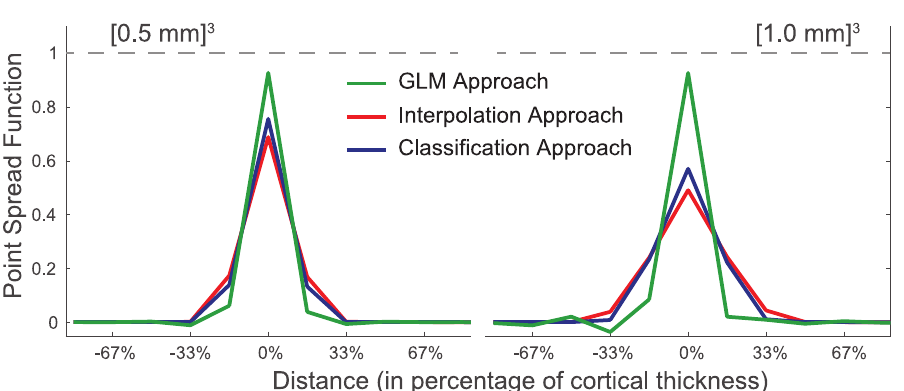
Fig 5. The performance of the three different approaches of obtaining layer signal, represented as a point spread function (PSF) obtained on simulated data. An ideal PSF would be an unit peak at the origin. The results are shown for approximate resolutions of 0.5 mm and 1.0 mm, on the left and right respectively. The GLM approach has a sharper PSF and is able to retrieve more signal, but potentially at the cost of a small undershoot in neighbouring